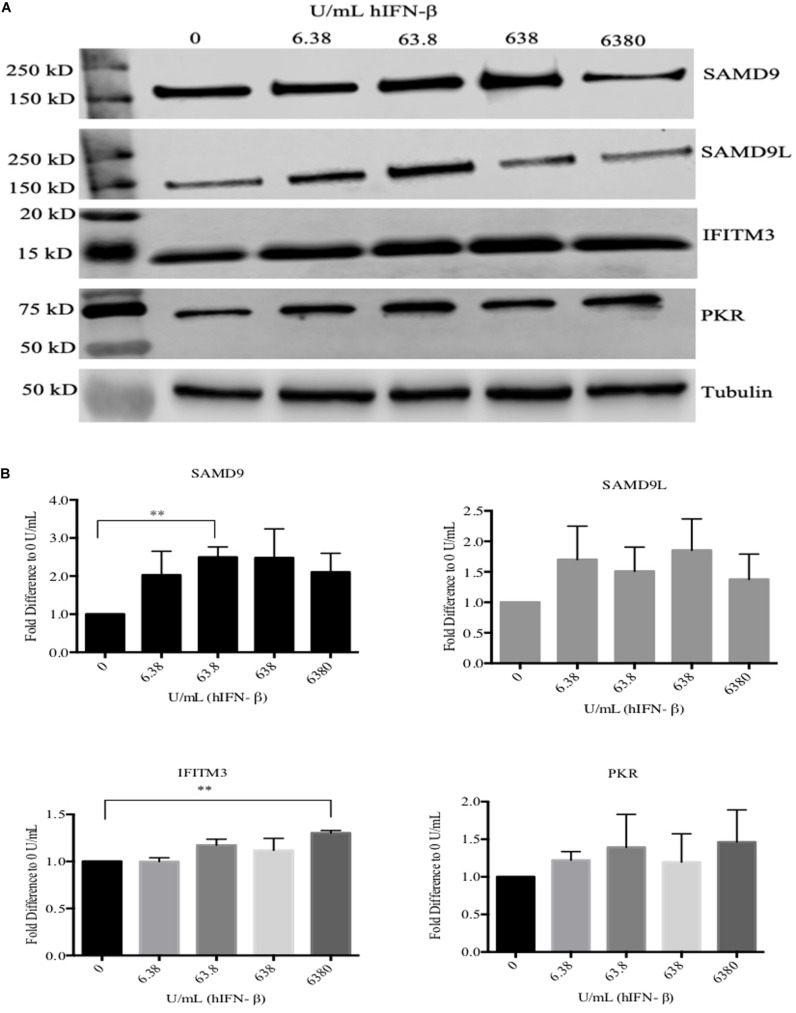
Western blot analysis of selected ISGs in HDFs treated with hIFN-β. Cells were treated with hIFN-β at the concentrations shown for 6 h. SAMD9, SAMD9L, IFITM3, and PKR were detected with their respective antibodies by Western blotting. Anti-tubulin antibody was used as a loading control (A). The band intensity was quantified using Image StudioTM then normalized to tubulin and further normalized to 0 U/mL of IFN (B). Error bars represent ± SEM from three independent experiments (**p < 0.01, Student T-Test).